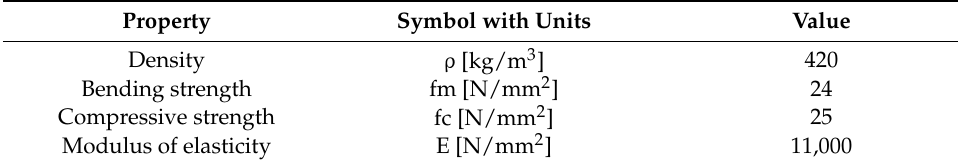
Table 2. Material properties of timber C24 [34].